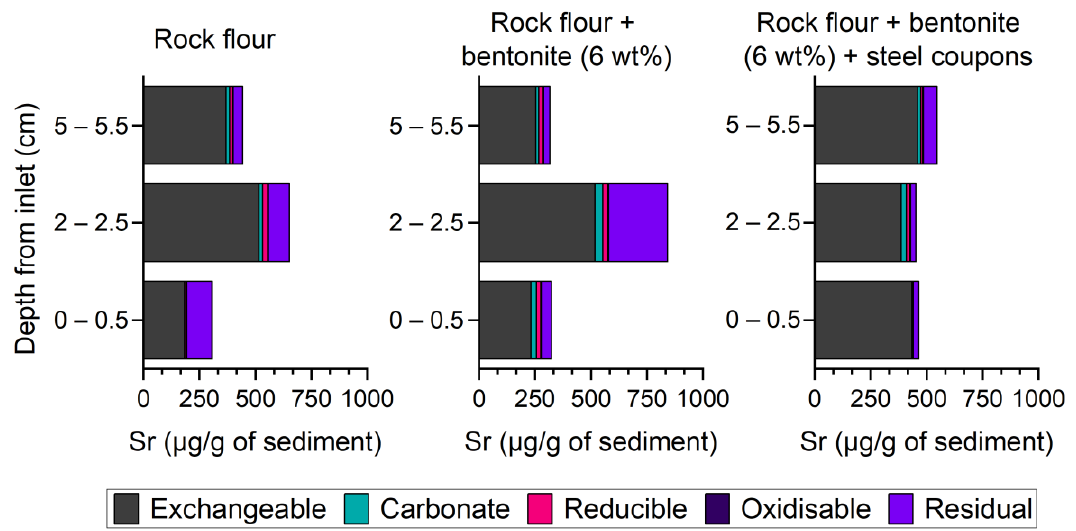
Figure 3. Concentration of Sr extracted per lixiviant (see key) from selected column material samples (0.5 cm depth horizons) from the following: rock flour, rock flour + bentonite (6 wt.%), and rock flour + bentonite (6 wt.%) + steel coupons. Sr that was extractable from the original starting materials (rock flour + bentonite 6 wt.%) was subtracted from the data before plotting (Supplementary Materials Table S2). The repeatability of the extraction was assessed by conducting a triplicate extraction of samples taken from the 0–0.5 cm section of the rock flour column system. Therein, the variability was 2.00%, 0.50%, 0.30%, 0.01%, 0.03%, and 6.00% for Sr extracted from the respective fractions.